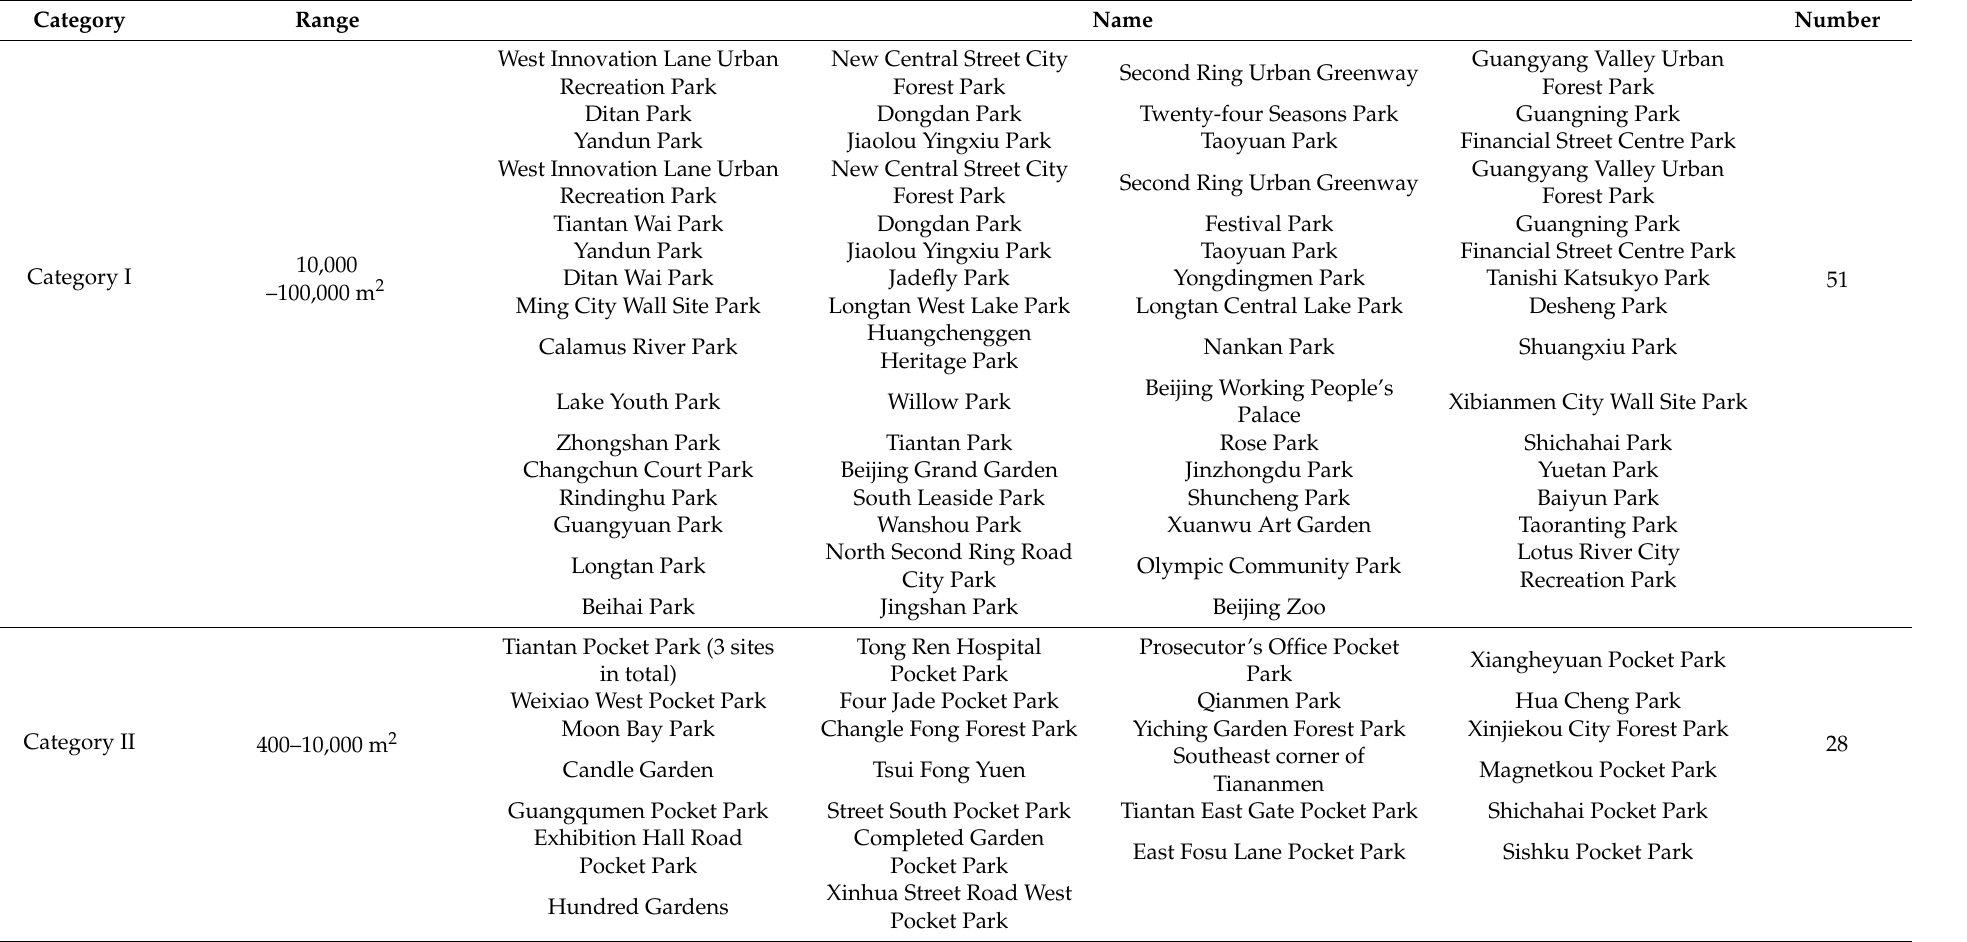
Table 1. Statistical table of registered parks in the core area of